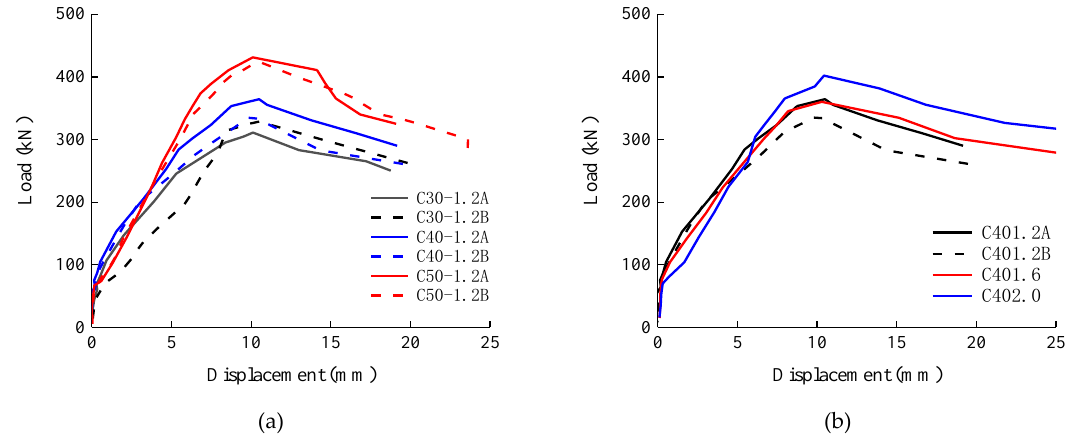
Figure 9. The mid-height lateral displacement versus load curves: ( a ) Concrete strength; ( b ) Volume fraction of steel fiber.